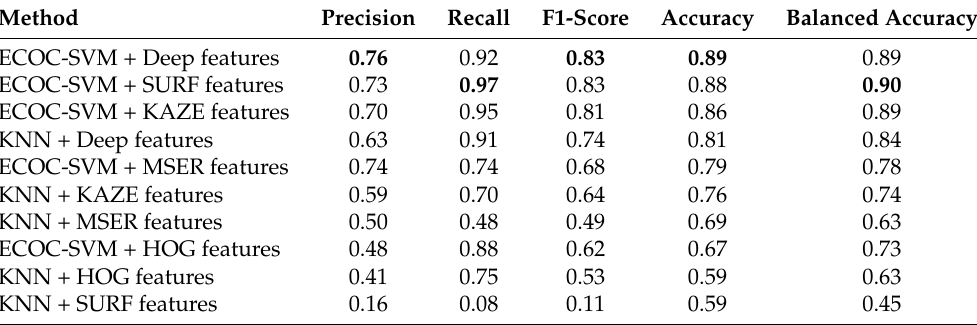
Table 2. The precision, recall, f1-score, accuracy, and balanced accuracy of the proposed and evalu- ation methods on the test data set. The precision, recall, f1-score, accuracy, and balanced accuracy values range from 0 to 1